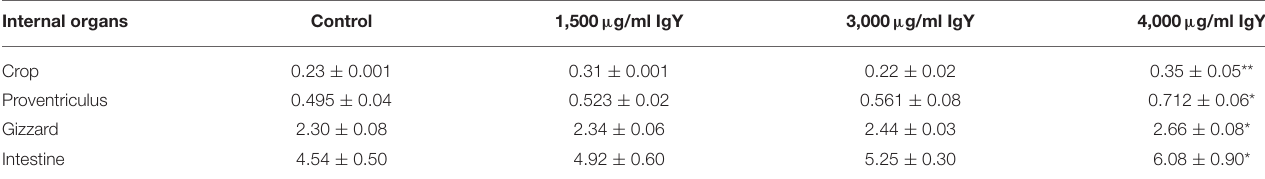
TABLE 3 | Weight of internal organs across the experimental